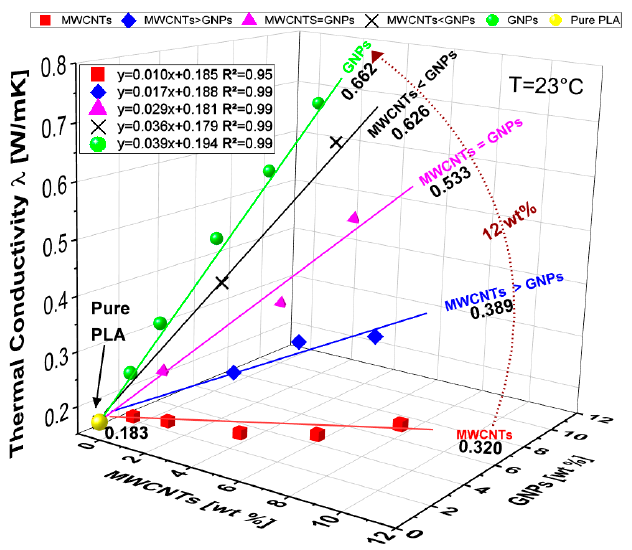
Figure 19. 3D plot of the thermal conductivity evaluated at 23 °C for pure PLA and composites with different filler concentrations. Markers represent experimental data, whereas lines are their interpolation curves.